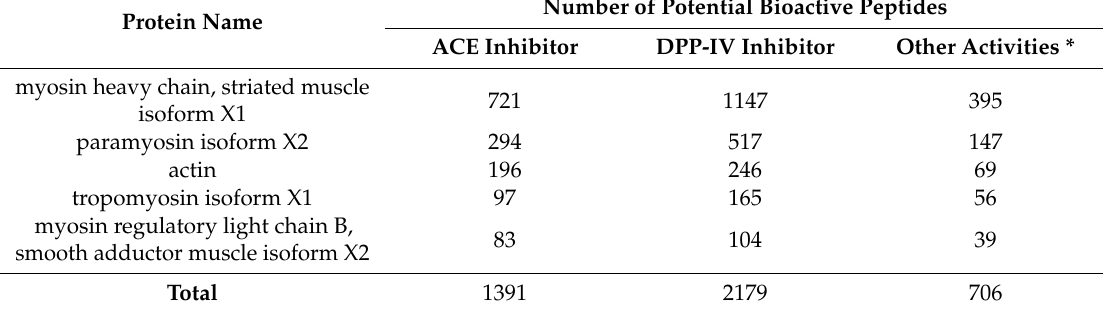
Table 2. Total number of potential bioactive peptides from oyster proteins predicted in silico using BIOPEP-UWM database (accessed on 6 March